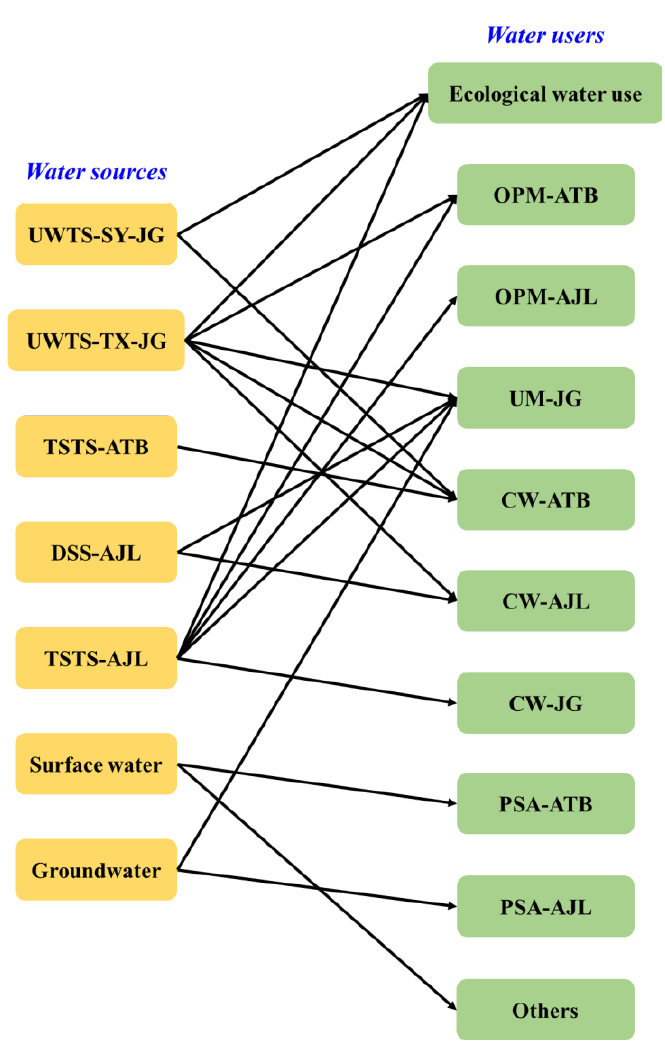
Figure 4. The relationship between supply and demand of water resources in mining areas after optimized allocation.